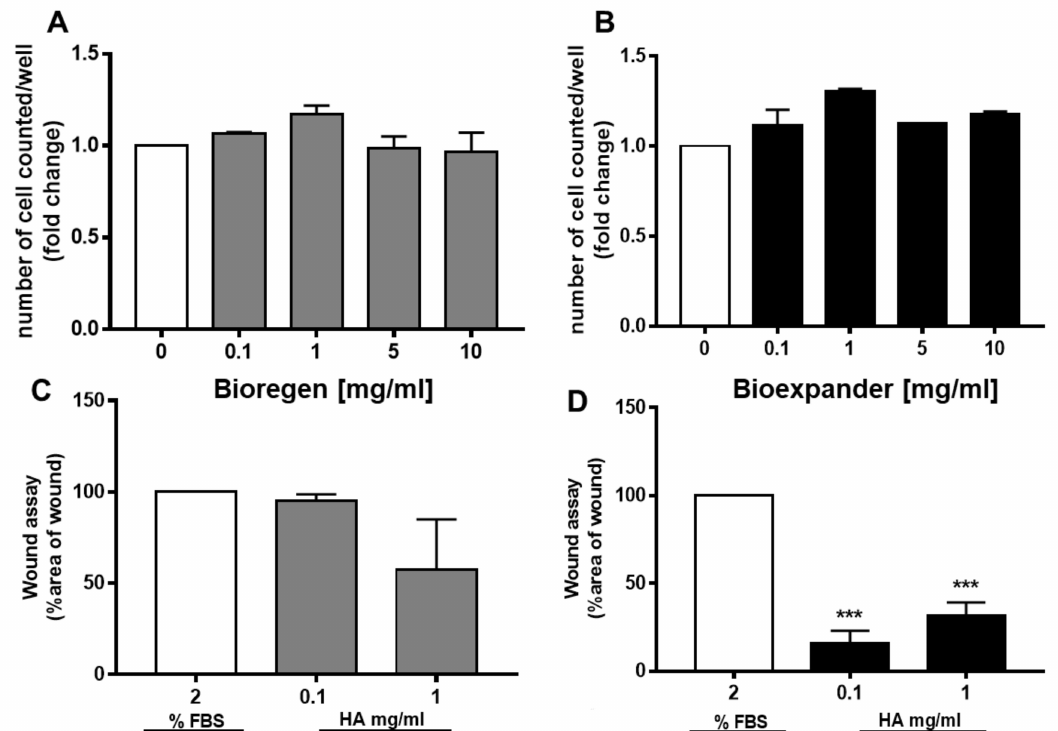
Figure 1. Fibroblast proliferation and migration in response to hyaluronic acid (HA) preparations. ( A , B ) Fibroblasts were exposed to increasing concentrations of the HA preparations Bioregen ® (grey columns) ( A ) and Bioexpander ® (black columns) ( B ) (0.1–10 mg / mL) for 48 h in a medium containing 2% serum. Cell number, index of survival, and proliferation were counted in a blind manner. (n = 3). ( C , D ) Migration of adherent cells was evaluated by the scratch assay in confluent fibroblast monolayers. The biomaterials Bioregen ® (grey columns) (C) and Bioexpander ® (black columns) ( D ) were tested at 0.1 and 1 mg / mL concentrations in the presence of 2% fetal bovine serum (FBS). Graphs report the percentage of wound area with respect to time 0 (n = 3). *** p < 0.001 vs. basal